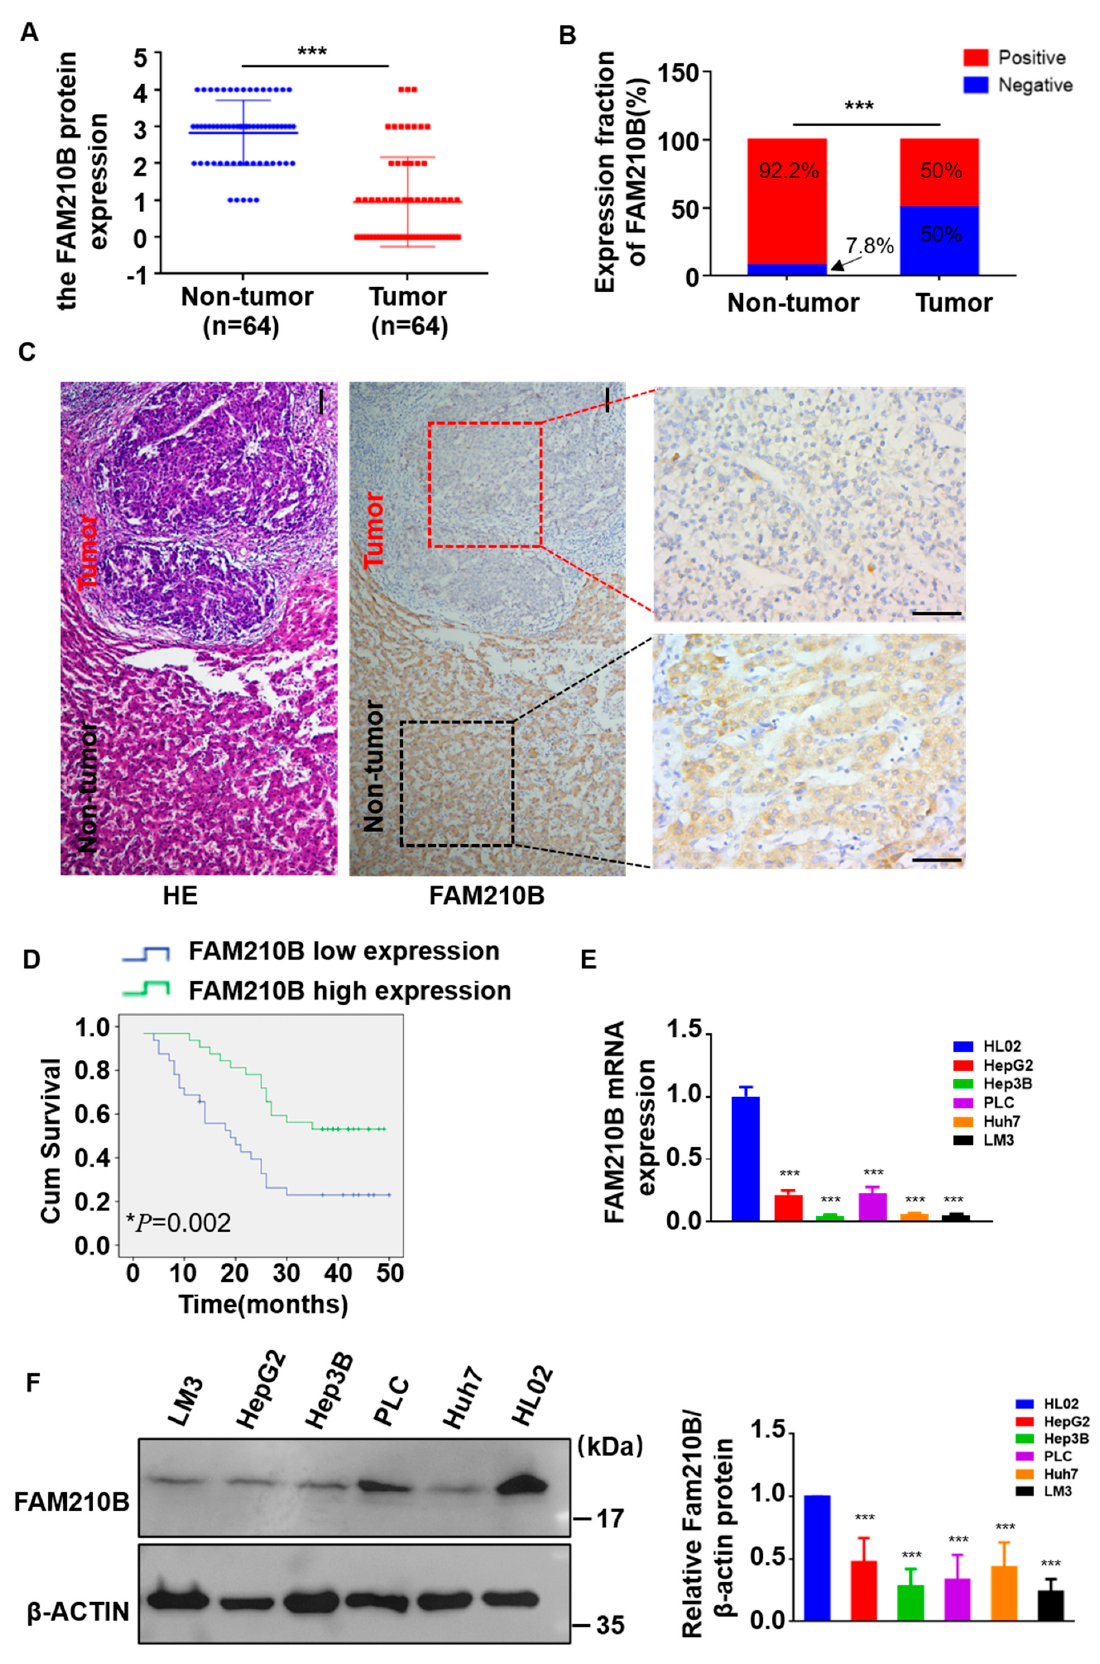
Figure 2. FAM210B was frequently downregulated in HCC. ( A ) The FAM210B levels were deter- mined in 64 HCC and paired non − tumor paraffin samples by immunohistochemistry (IHC)